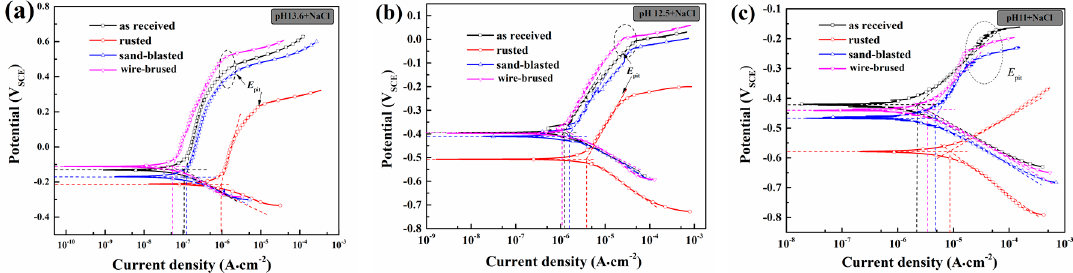
Figure 8. Potentio-dynamic curves of the rebar after exposure to Cl − -containing SCPS of different alkalinity for 40 days: ( a ) pH 13.6, ( b ) pH 12.5, and ( c ) pH 11. Table 3. The electrochemical parameters of the potentio-dynamic polarization (PDP) curves.